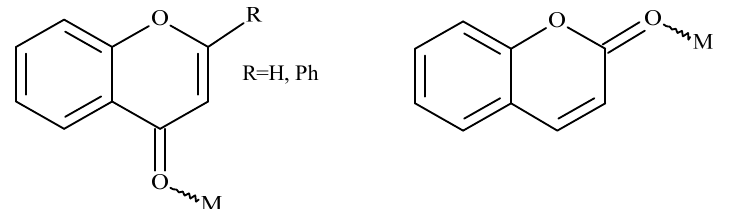
Figure 10. The query used in the search of the database.